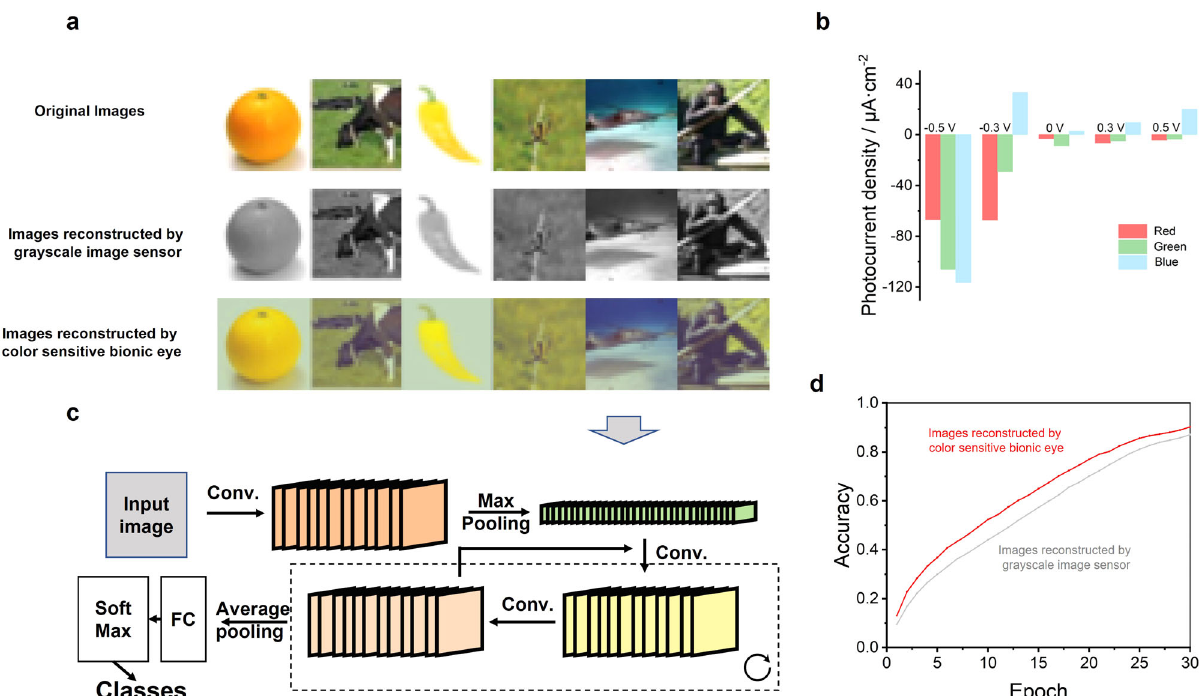
Fig. 3 | Color image reconstruction and image classi fi cation. a Samples of ima- ges from original and reconstructed datasets. b photocurrent density of biased arti fi cial retina under red (650nm, 11mW/cm 2 ), green (520nm, 11mW/cm 2 ), and